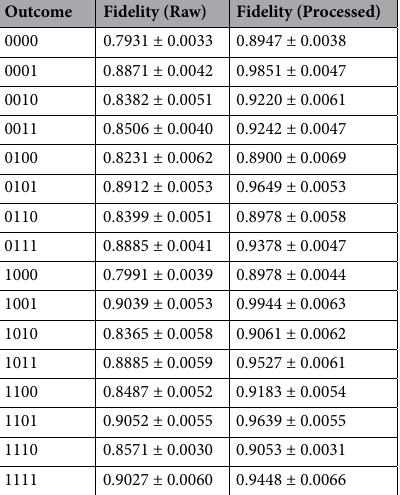
Table 5. Channel fidelities for the 16 random unitaries, corresponding to the 16 different measurement outcomes, generated with the approximate 2-design on the ibmq_sydney quantum processor. ‘Raw’ shows the channel fidelities without quantum readout error mitigation. ‘Processed’ shows the channel fidelities with quantum readout error mitigation.